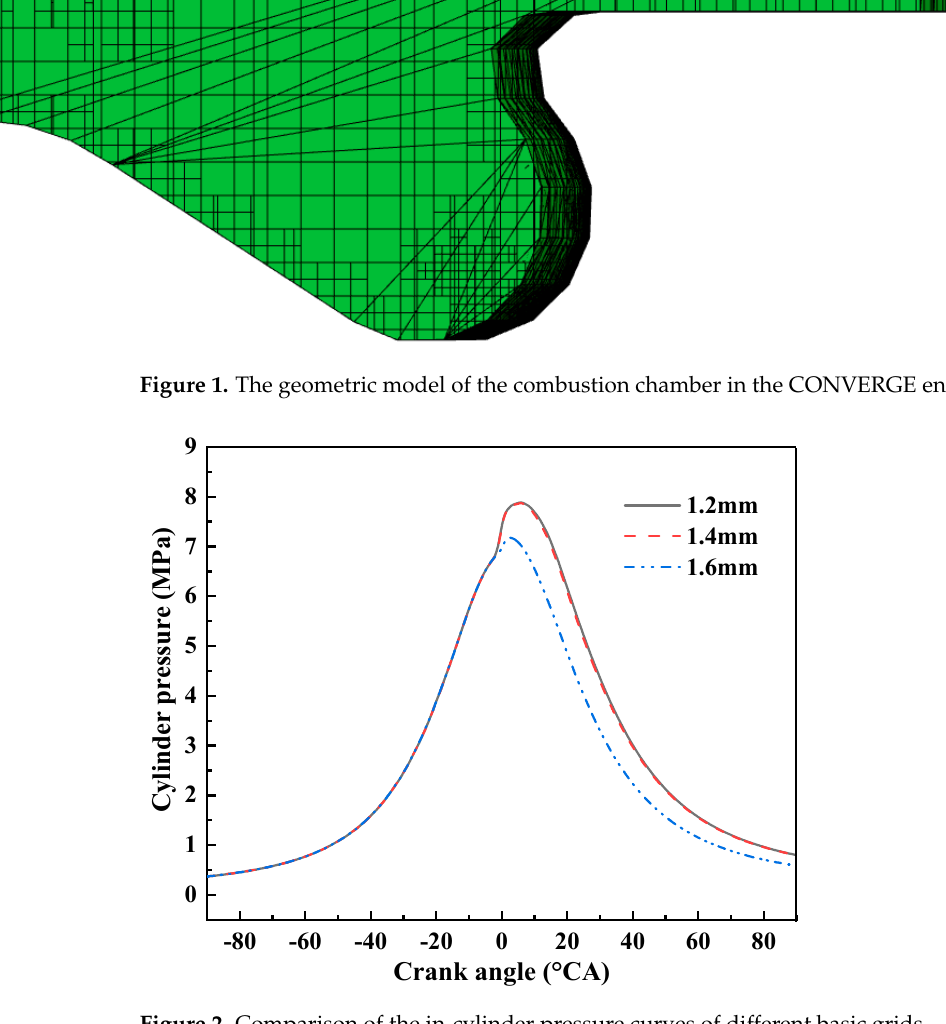
Table 2. Fuel physical properties.